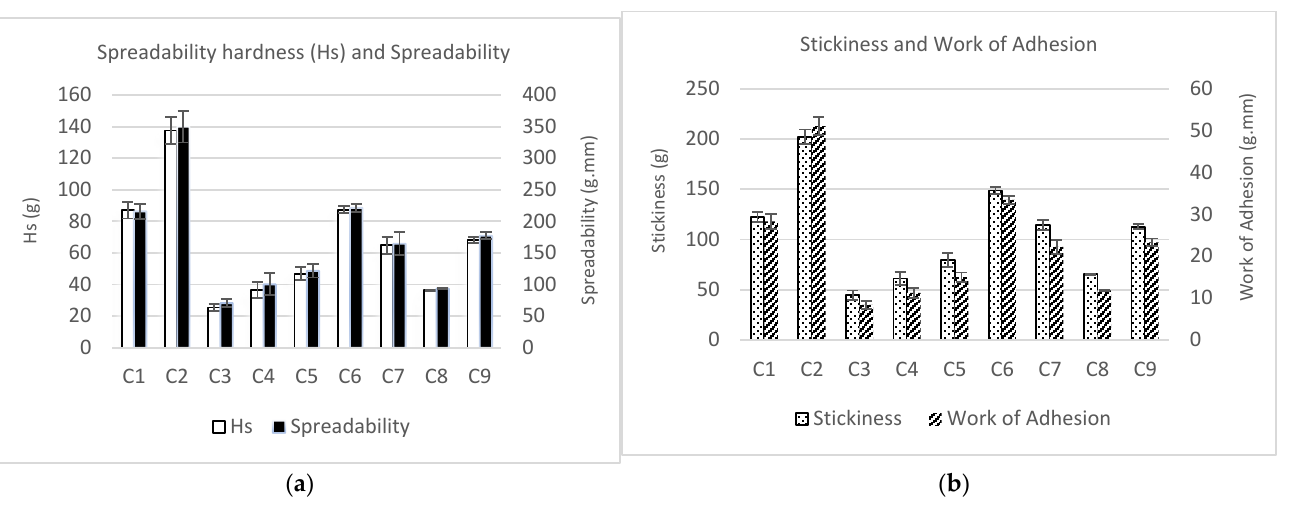
Figure 3. Instrumental texture analysis of the nine spreadable cheese analogues: firmness and spreadability ( a ) and stickiness and work of adhesion ( b ). The samples, labelled from C1 to C9, contain different proportions of milk protein concentrate, faba bean protein concentrate and insect flour (MPC/FBP/IF): C1 (100/0/0), C2 (50/50/0), C3 (0/50/50), C4 (50/0/50), C5 (75/0/25), C6 (75/25/0), C7 (25/50/25), C8 (25/25/50) and C9 (50/25/25).